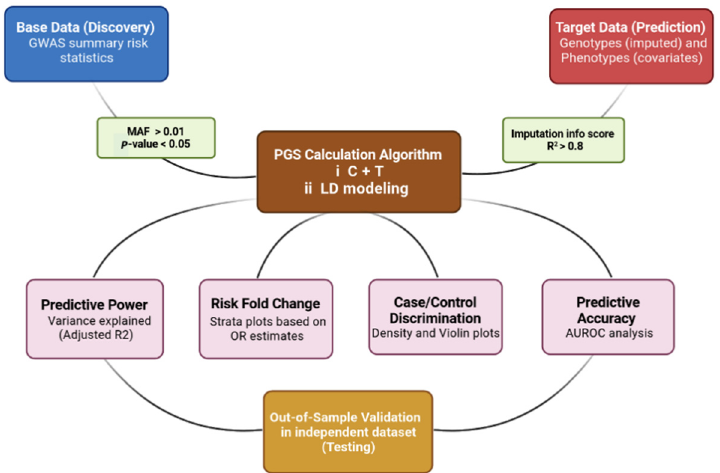
Figure 1. PRS calculation, results, and validation workflow. Summary risk statistics data should be filtered of rare variants (MAF > 0.01) and insignificant variants ( p -value < 0.05). Additionally, target data-imputed genotypes should be filtered with a filter score (R 2 ) of 0.8. In the PRS calculation box, C+T stands for clumping plus thresholding implemented in tools, e.g., PRSice software and LD modeling includes methods using shrinkage strategies implemented in tools, e.g.,